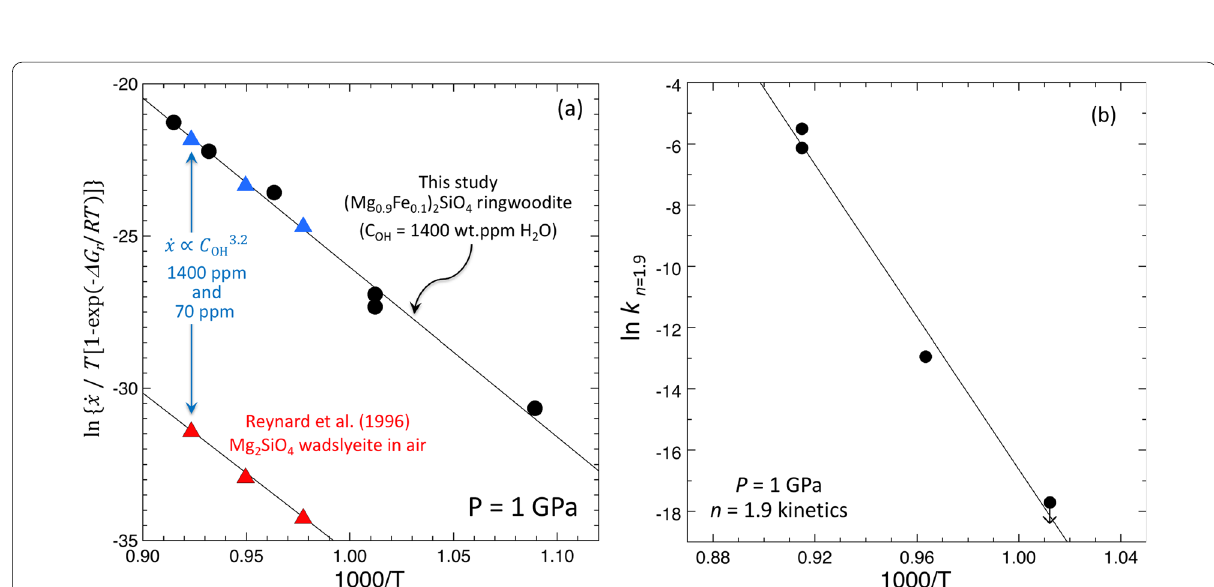
Fig. 12 Analysis of pressure and temperature dependences of the back-transformation rate. For plotting purposes, the data are plotted after corrections to the pressure of 1 GPa using the activation volume determined in this study. Obtained kinetic parameters are summarized in Table 3. a Fits of the growth rate data in the ringwoodite-olivine (black circles; this study) and in the wadsleyite-olivine (red triangles; Reynard et al. 1996; Hu and Sharp 2017) back-transformations to Eq. (3). Large discrepancies between these growth rate data correspond to the difference in water contents by about 20 times (red and blue triangles) considering the water content exponent of 3.2 (see text). b Fits of the k data in the orthoenstatite crystallization from amorphous bridgmanite to Eq.